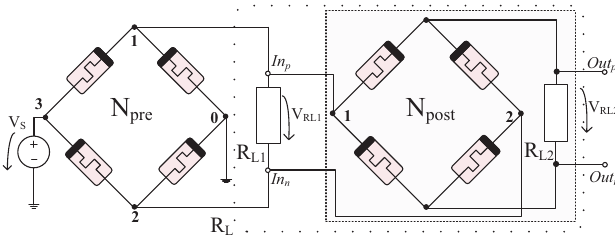
Fig. 12 : Schematic of two combined